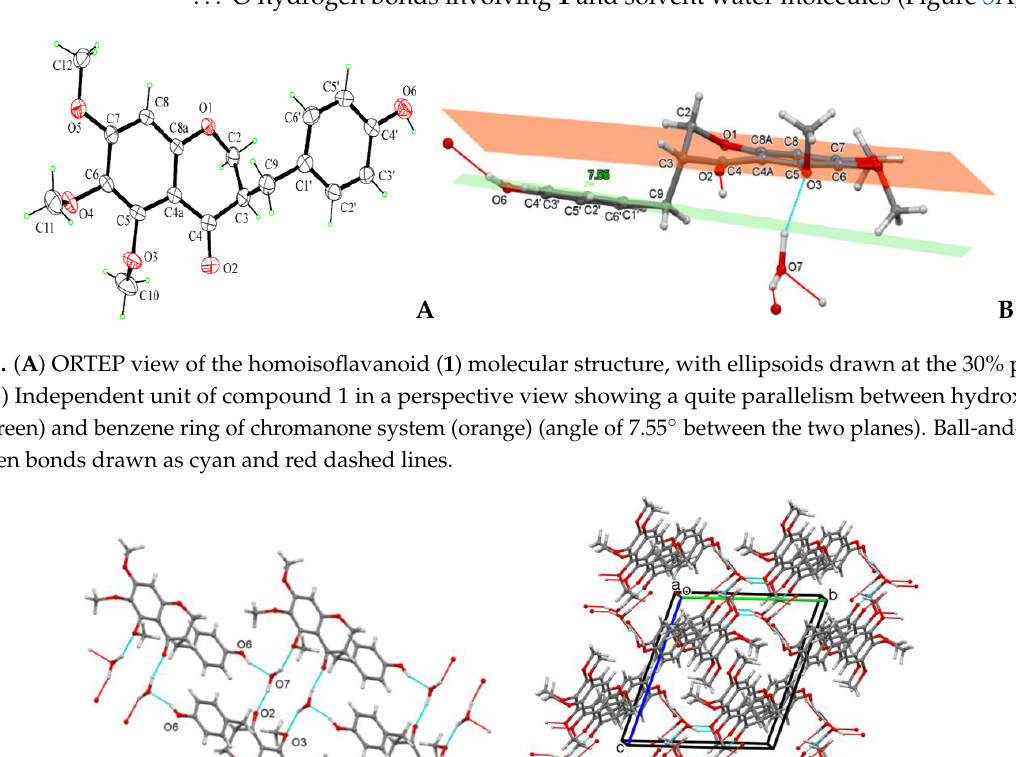
Figure 4. Experimental ECD spectra of homoisoflavanoids ( 1 ) (black solid line), and 4 (red line).